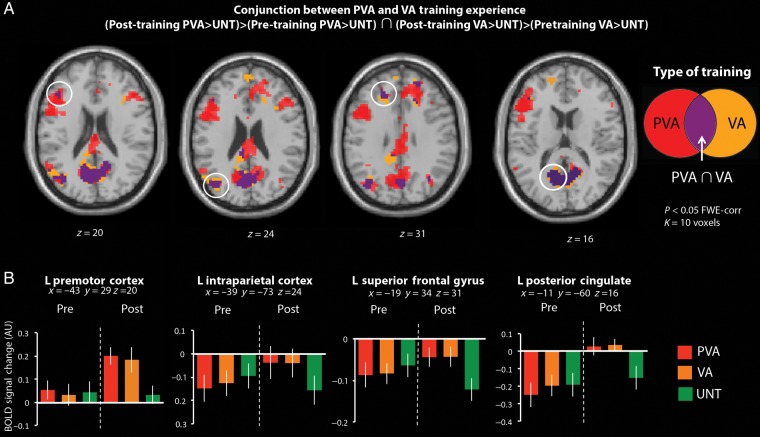
Conjunction analysis illustrating brain regions common to the PVA > UNT and VA > UNT contrasts, across scan session. (A) Four regions showed overlap with PVA and VA experience, including left premotor cortex, left intraparietal cortex (IPC), left superior frontal gyrus (SFG), and posterior cingulate cortex. (B) Plots show the percent BOLD signal change (in arbitrary units) for each condition in these 4 common regions that met the established cluster-corrected threshold (PFWE-corrected < 0.05, k = 10 voxels), for each scanning session and are included for illustration purposes only. Error bars indicate the across-subject standard error of the mean.